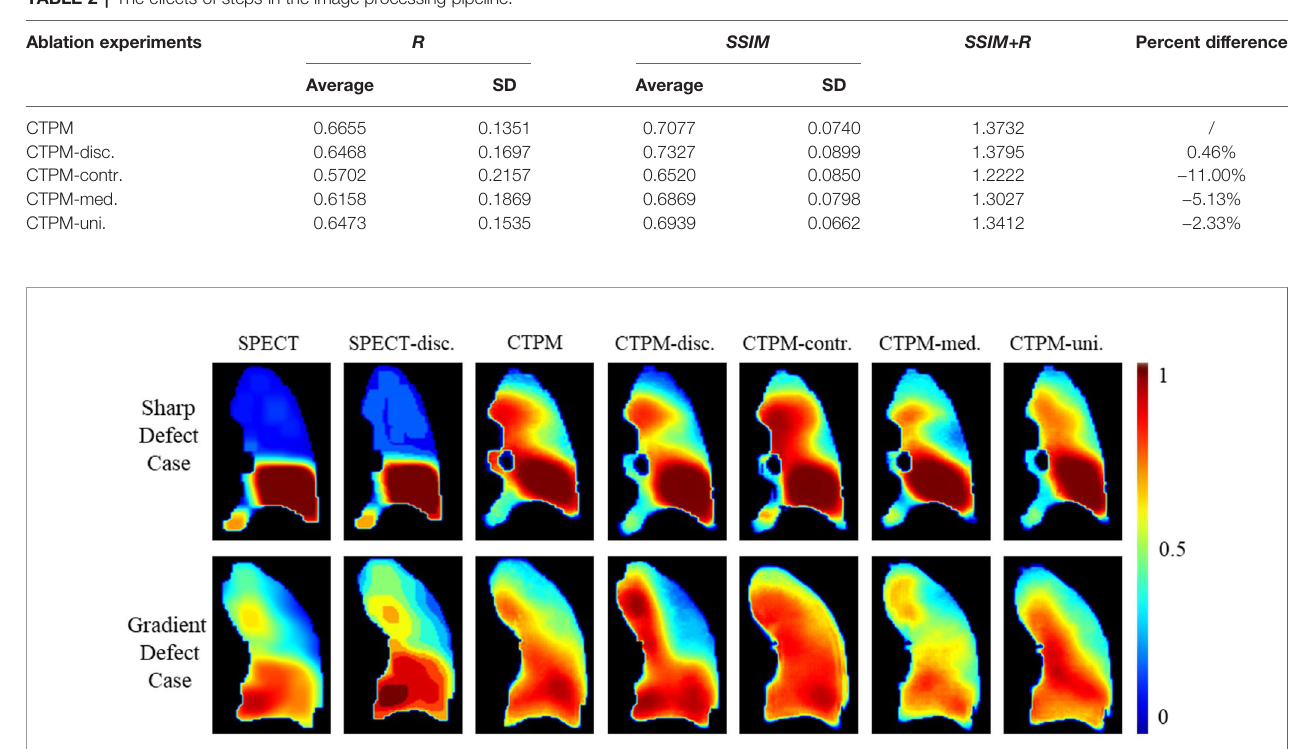
TABLE 2 | The effects of steps in the image processing pipeline.